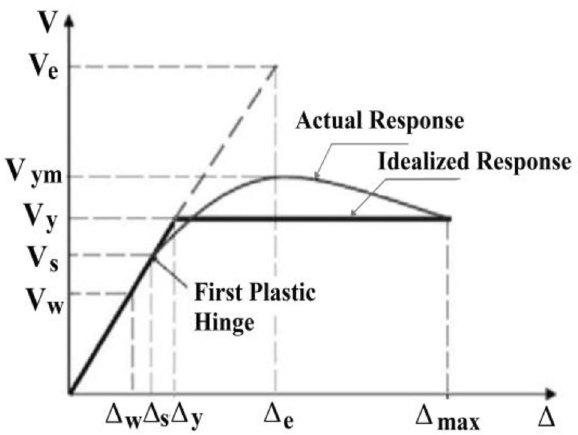
Fig. 3 General behavior of force–displacement of